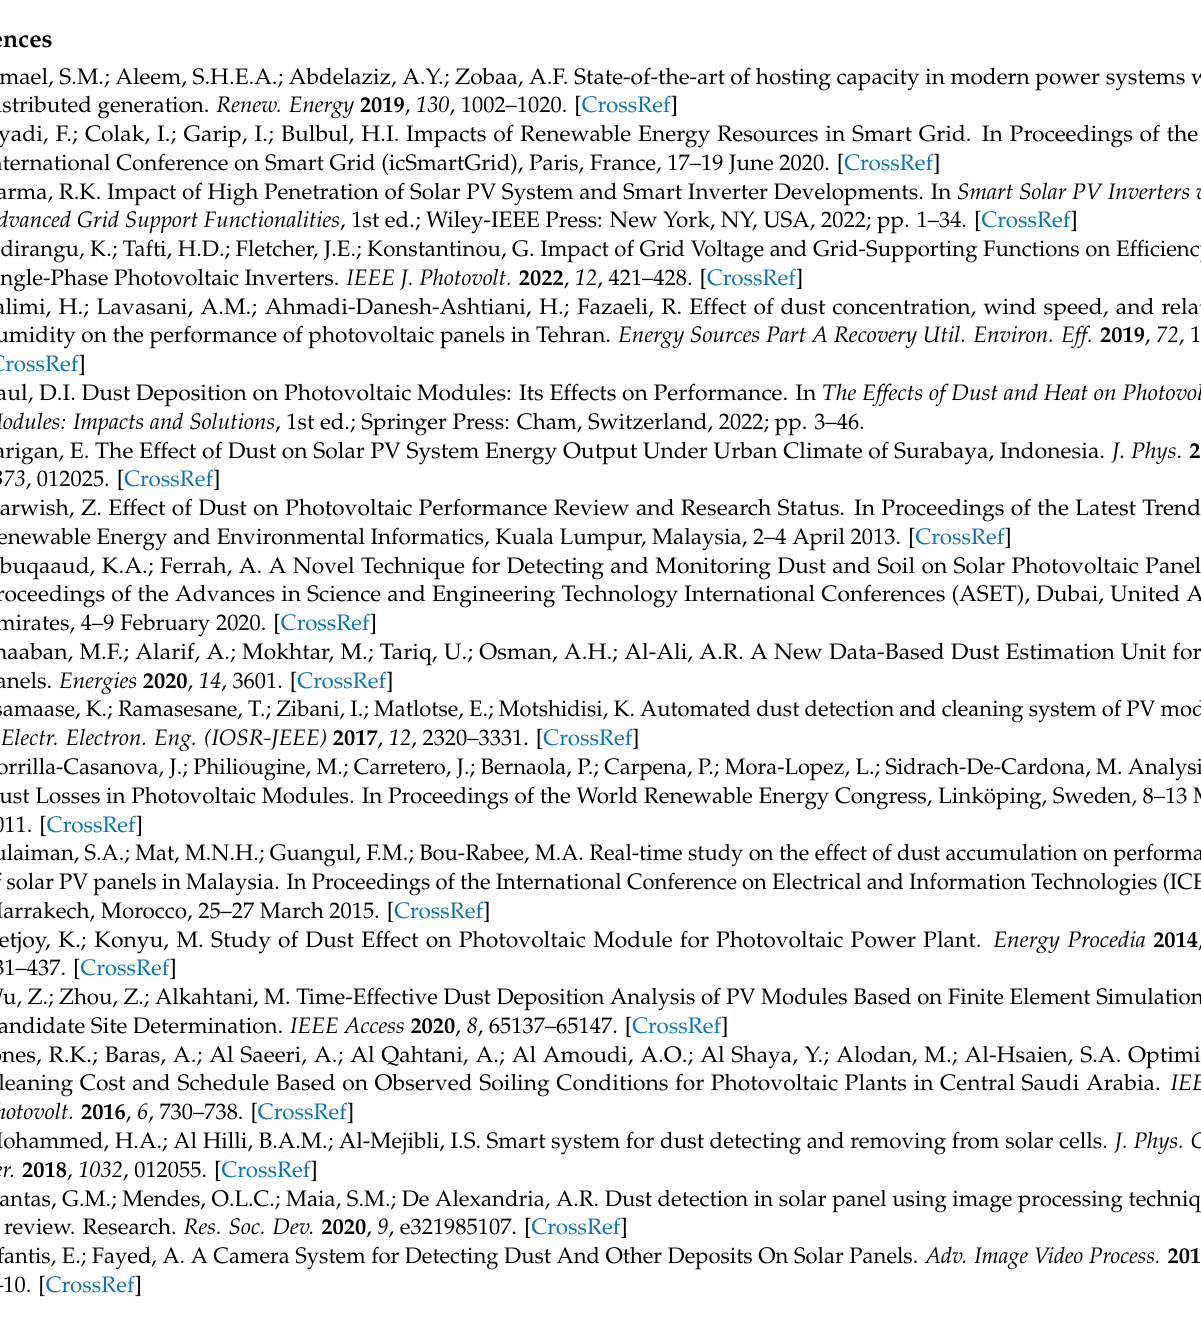
Figure 18. Current–voltage heat characteristic used in this study [34]. Figure A1. Current–voltage heat characteristic used in this study